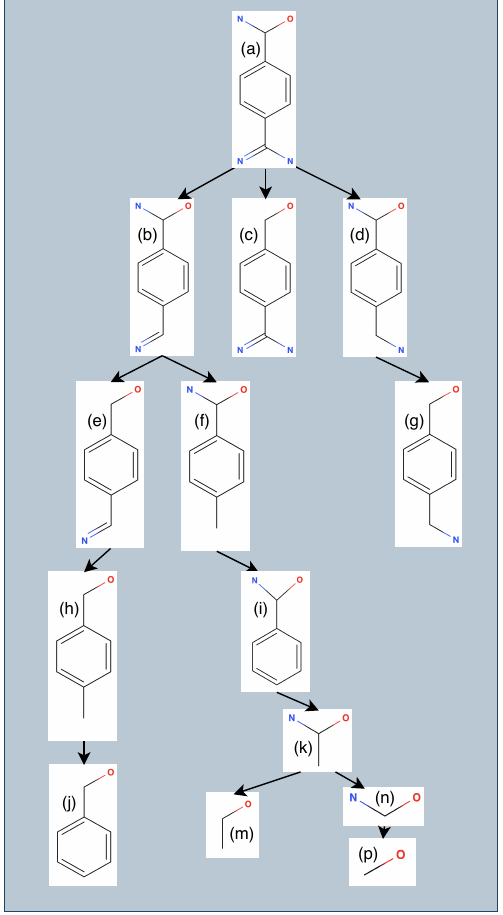
Figure 3. Mock ligand and tree structure paths for generating an example set of 14 ligand variants. The oxygen is the root of the ligand because it engages in a stabilizing interaction with the protein; consequently, the oxygen is a member of each ligand variant. A depth-first traversal of the tree represents successive removals of atoms. Variants (b), (c), (d), for example, are all variants that have one atom less than the ligand that is the root of that tree